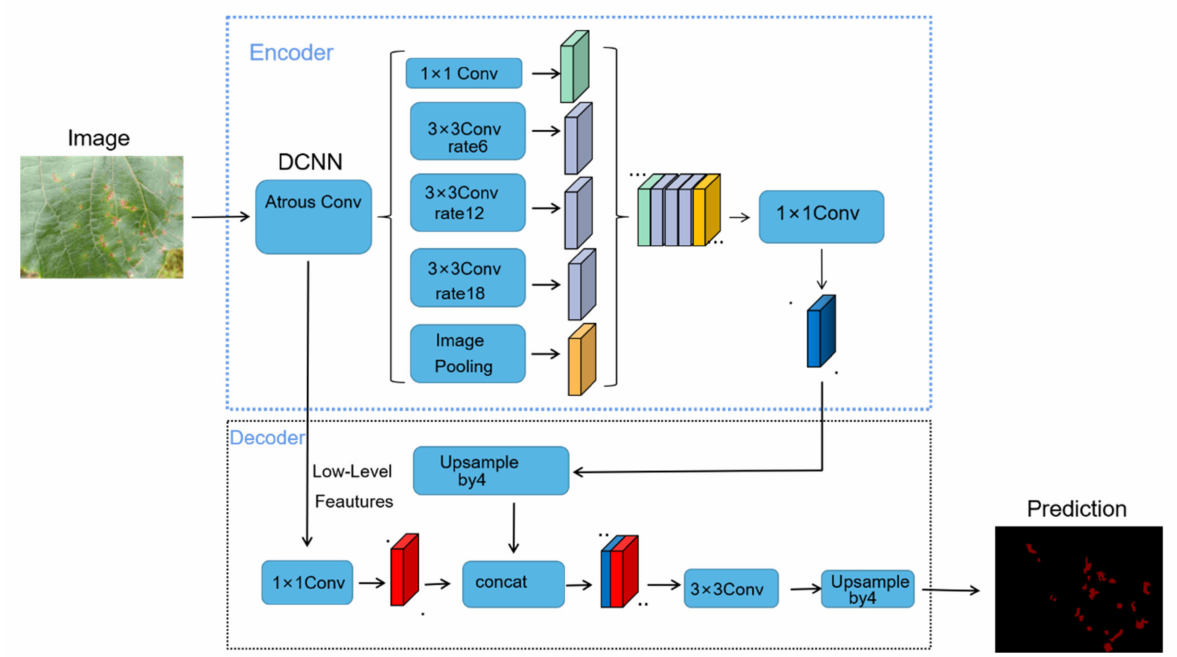
Figure 3. DeepLabv3+ network structure diagram, where, .., . . . are the symbol of